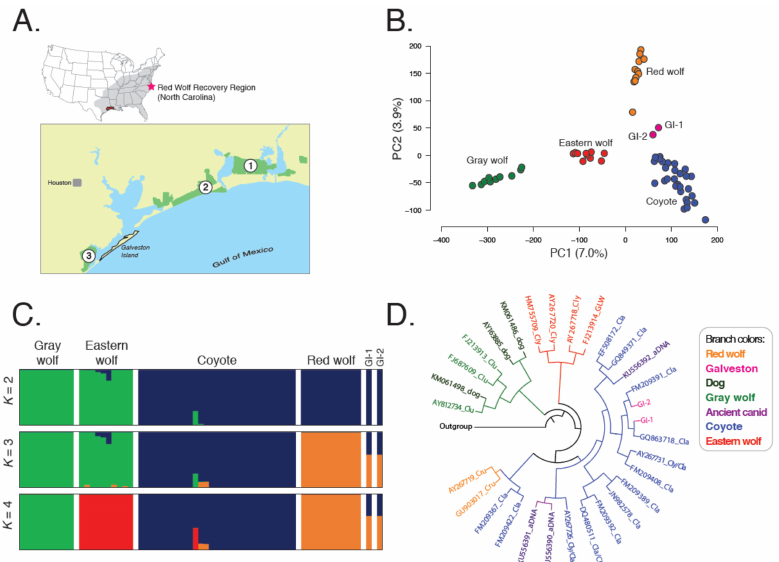
Figure 1. Analyses of genome-wide single nucleotide polymorphism (SNP) and mitochondrial DNA (mtDNA) data across all legally recognized wild Canis species and two canids from Galveston Island.